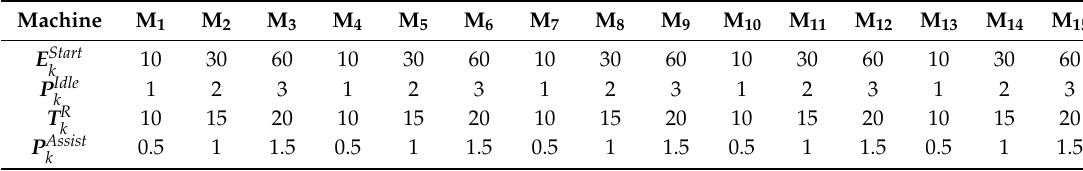
Table 4. The energy consumption data for the machines.